Question: Write the caption for this figure.
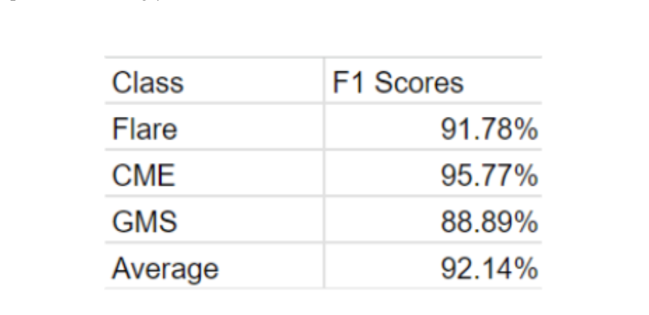
Answer: Table presenting F1 Scores of the model in each class. The model performed strongly in each of these categories.